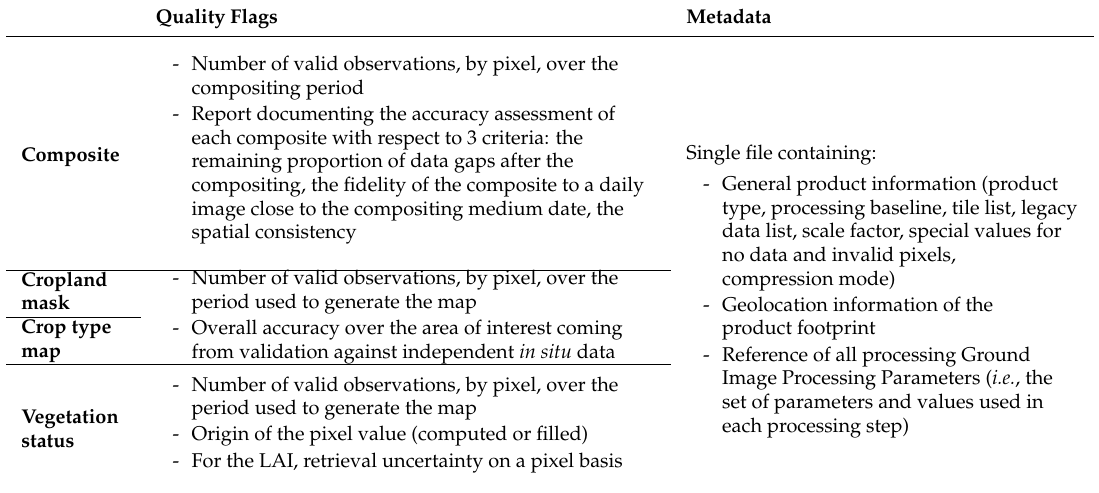
Table 1. Quality flags and metadata associated with each